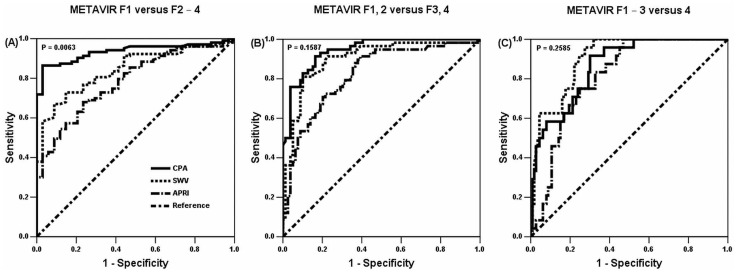
ROCa curves dichotomizing liver fibrosis stages.To dichotomize F1 versus F2–4 (A), the AUROCb for the CPAc was 0.9349 (95% confidence interval: 0.8943–0.9755) and SWVd was 0.8434 (0.7762–0.9105) (CPA versus SWV, P = 0.0063). For F1, 2 versus F3, 4 (B), the CPA was 0.9436 (0.9091–0.9781); SWV was 0.8997 (0.8444–0.9551) (P = 0.1587). For F1–3 versus F4 (C), the CPA was 0.8647 (0.7944–0.9349); SWV was 0.9036 (0.8499–0.9573) (P = 0.2585). APRIe was incorporated too. areceiver operating characteristic; barea under ROC curves; ccollagen proportionate area; dshear wave velocity; easpartate transaminase-to-platelet ratio index.